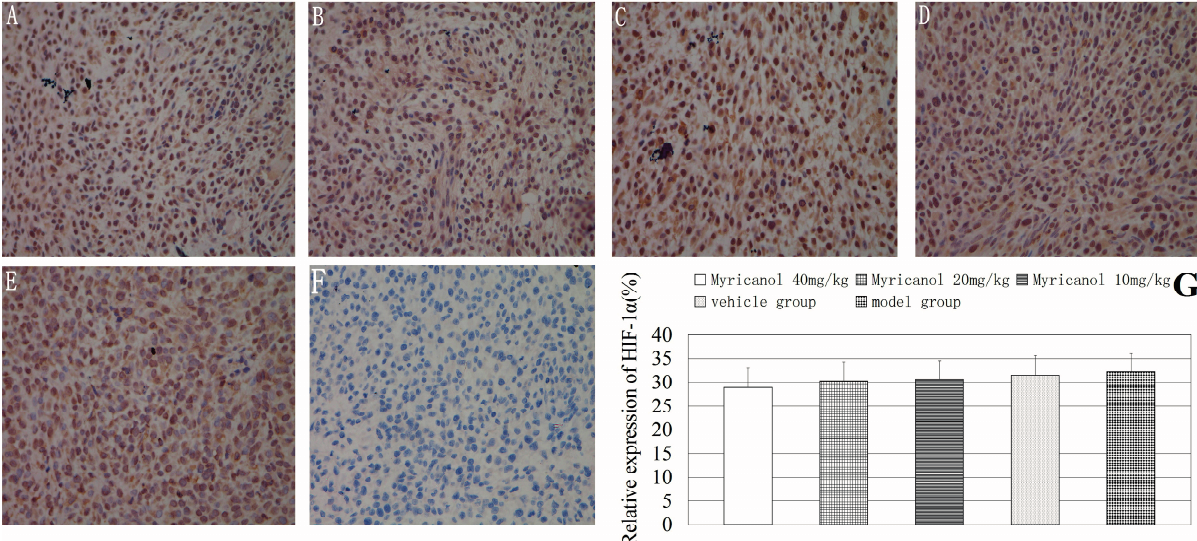
Figure 6. Immunohistochemical detection of HIF-1 α protein in A549 cells (magnification of 400×). The relative expression of HIF-1 α was determined by NIS-Elements D 3.2 image analysis system. ( A ) Myricanol with 40 mg/kg; ( B ) myricanol with 20 mg/kg; ( C ) myricanol with 10 mg/kg; ( D ) vehicle control group; ( E ) tumor model group; and ( F ) isotype control. The yellow and brown particles represent positive VEGF expression; ( G ) Quantification of protein expressions in different groups by IHC.